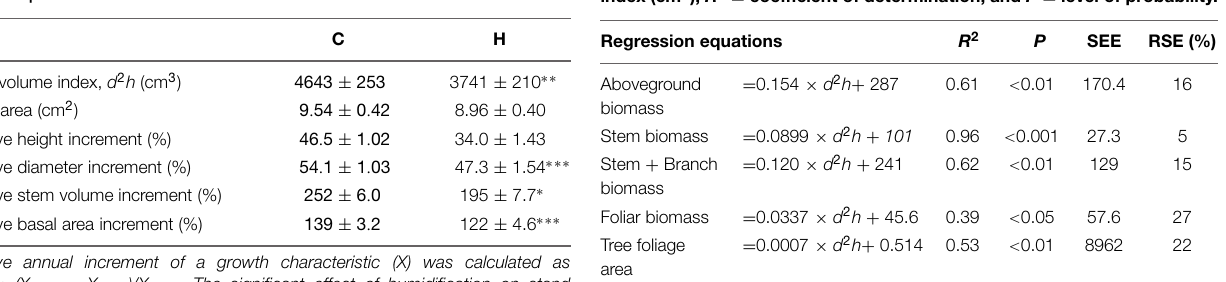
TABLE 2 | Regression equations for estimating biomass of aboveground tree compartments (g) and tree leaf area (cm 2 ), where d 2 h = stem volume index (cm 3 ), R 2 = coefficient of determination, and P = level of